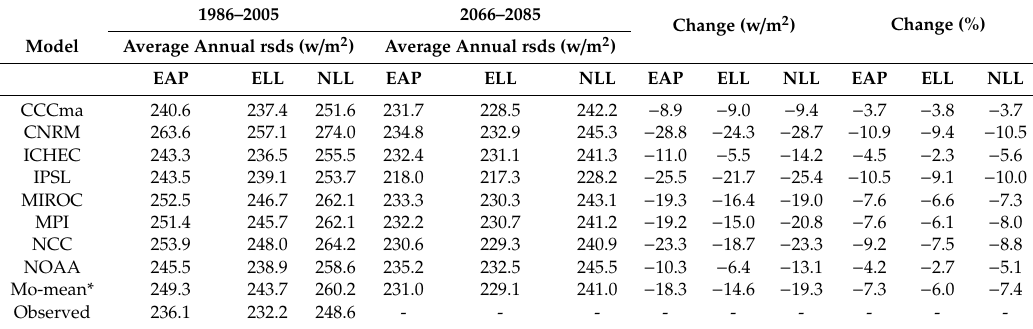
Table 7. Changes in inter annual solar irradiance